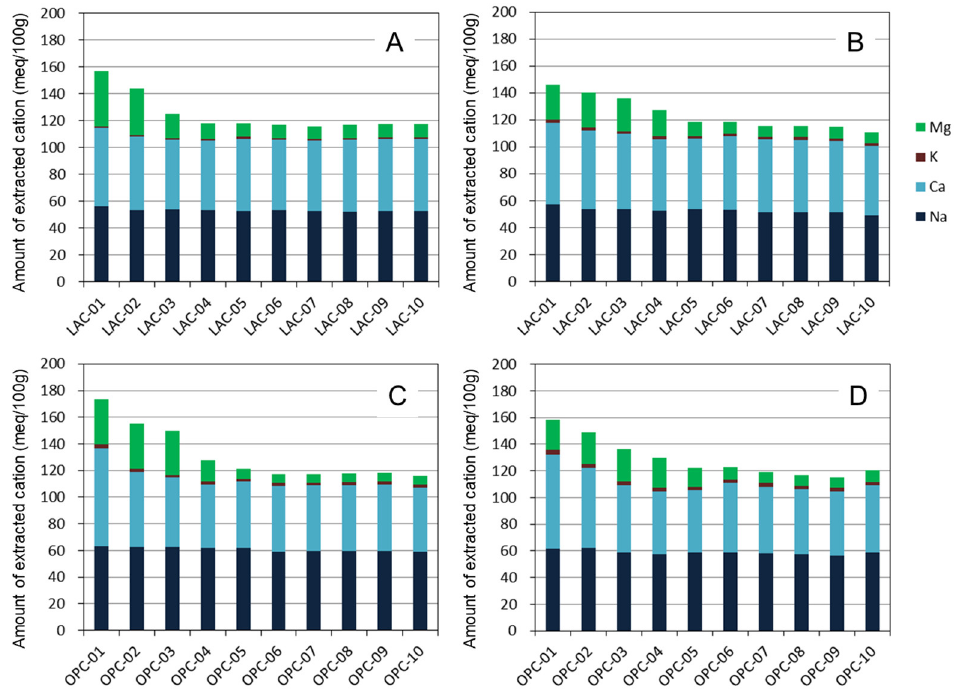
Figure 6. Extracted cation compositions of bentonite by a 1 M NH 4 Cl solution. ( A ) LAC-MX_4.9 y, ( B ) LAC-MX_10 y, ( C ) OPC-MX_4.9 y, and ( D ) OPC-MX_10 y.